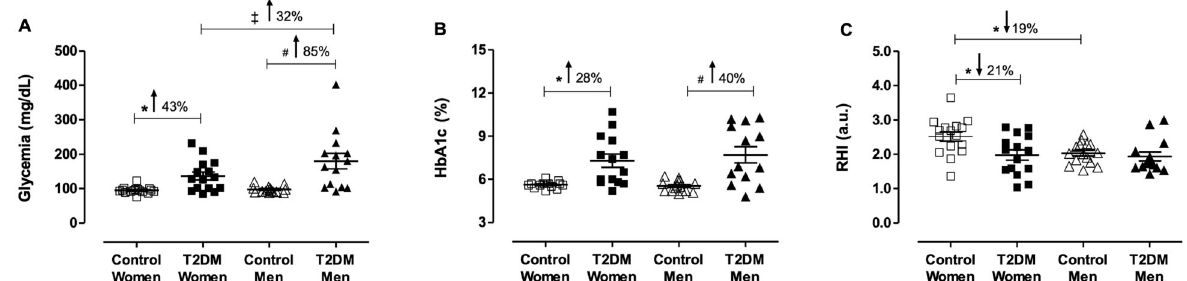
Figure 1. Microvascular function and glycemic pro fi le of groups. Groups: non-diabetic postmenopausal women (control women), postmenopausal women with type-2 diabetes (T2DM women), non-diabetic men (control men), and men with T2DM (T2DM men). A , Glycemia; B , Glycated hemoglobin A1c (HbA1c); C , Reactive hyperemia index (RHI, a.u. arbitrary unit). Data are reported as means ± SE. * # = P o 0.05 (two-way